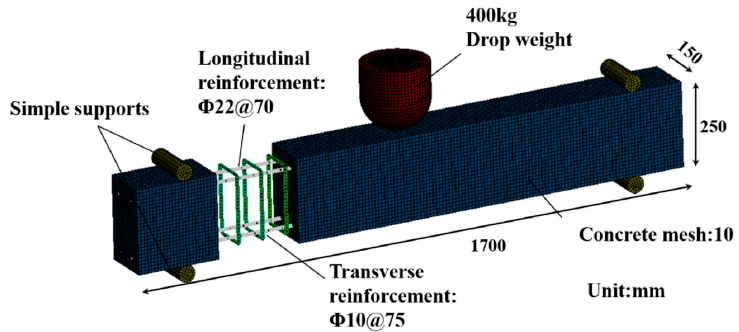
Figure 3. Numerical analysis model of the RC beam.